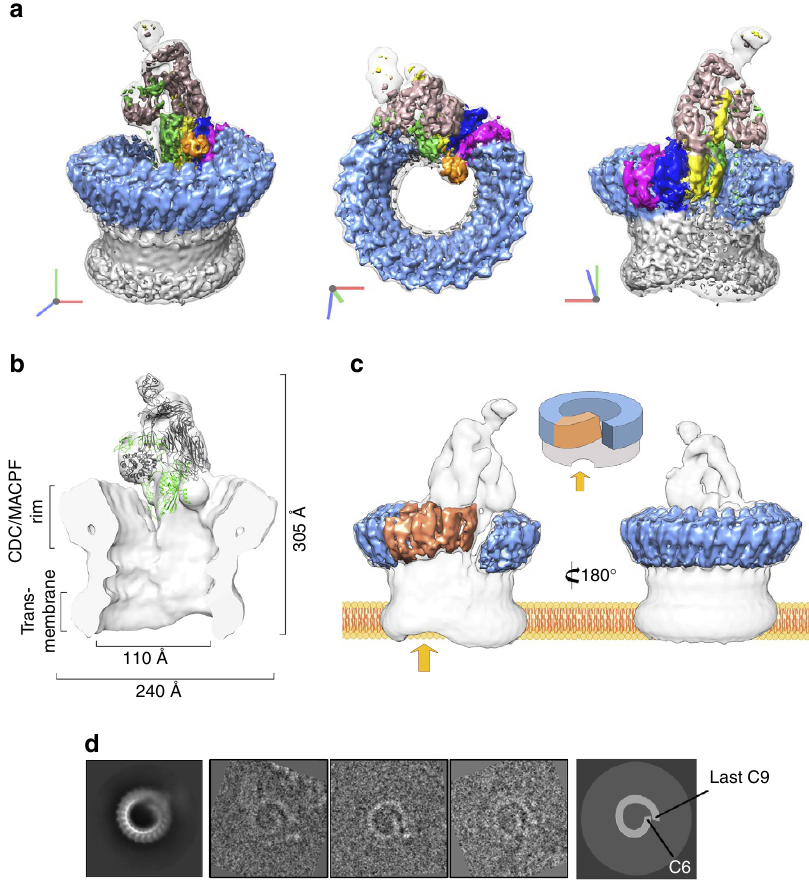
Figure 1 | Cryo-EM reconstruction of the MAC. ( a ) Sharpened map segmented and coloured according to complement proteins: C5b (tan), C6 (green), C7 (yellow), C8 a (magenta), C8 b (dark blue), C8 g (orange) and C9 (light blue). CDC/MACPF b -barrel and detergent belt are in grey colour. Density is overlaid on the unsharpened map (transparent surface). Axes are shown. ( b ) Fitting of the C5b6 crystal structure into a cross-section of the unsharpened map (grey surface). C5b and C6 are in grey colour and green ribbons, respectively. ( c ) ‘Split-washer’ configuration of the MAC comprises 4 asymmetric (orange) and 18 symmetric (blue) staves. Incomplete membrane penetration of the b -barrel is indicated (arrow). ( d ) Reference-free aligned class average corresponding to a top view of the MAC (left panel) and representative raw images belonging to this class (middle panel), clearly showing the ‘split-washer’ shape of the rim. Cartoon schematic illustrating the location of C6 and the last C9 molecule in the previous images (right panel).